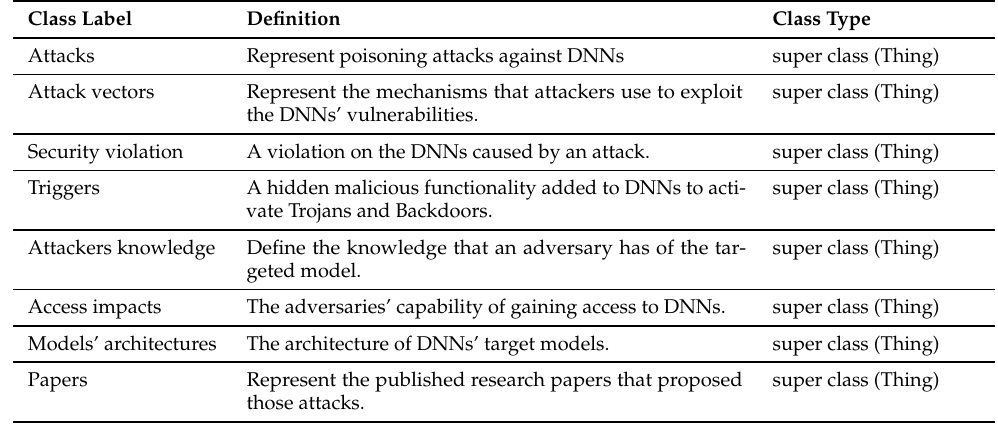
Figure 7. The DNNPAO ontology including classes and properties. Table 9. The definition of the main classes in